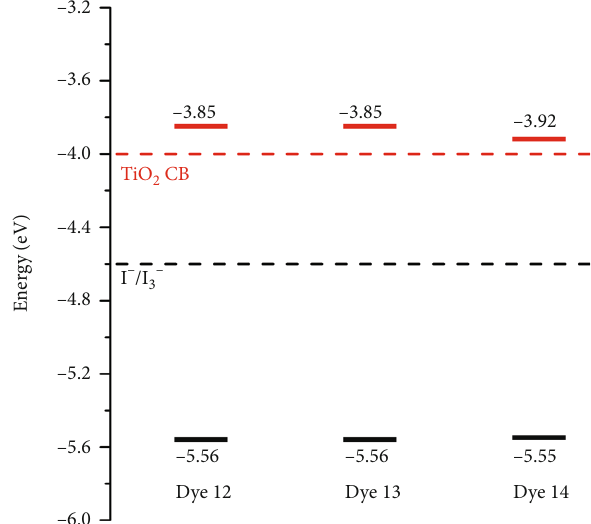
Figure 8: Energy level diagram. Δ SCF HOMO and LUMO energies (in eV) computed at M06-2X/6-311+G(d,p)//M06-2X/6-31G(d,p) in PCM/methanol.